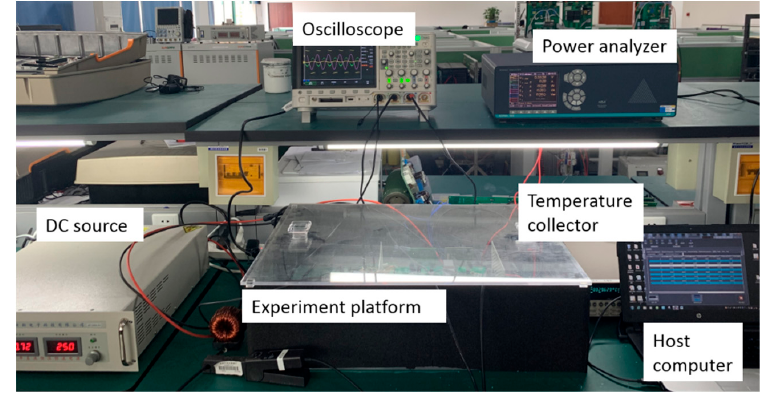
Figure 11. Experimental platform.